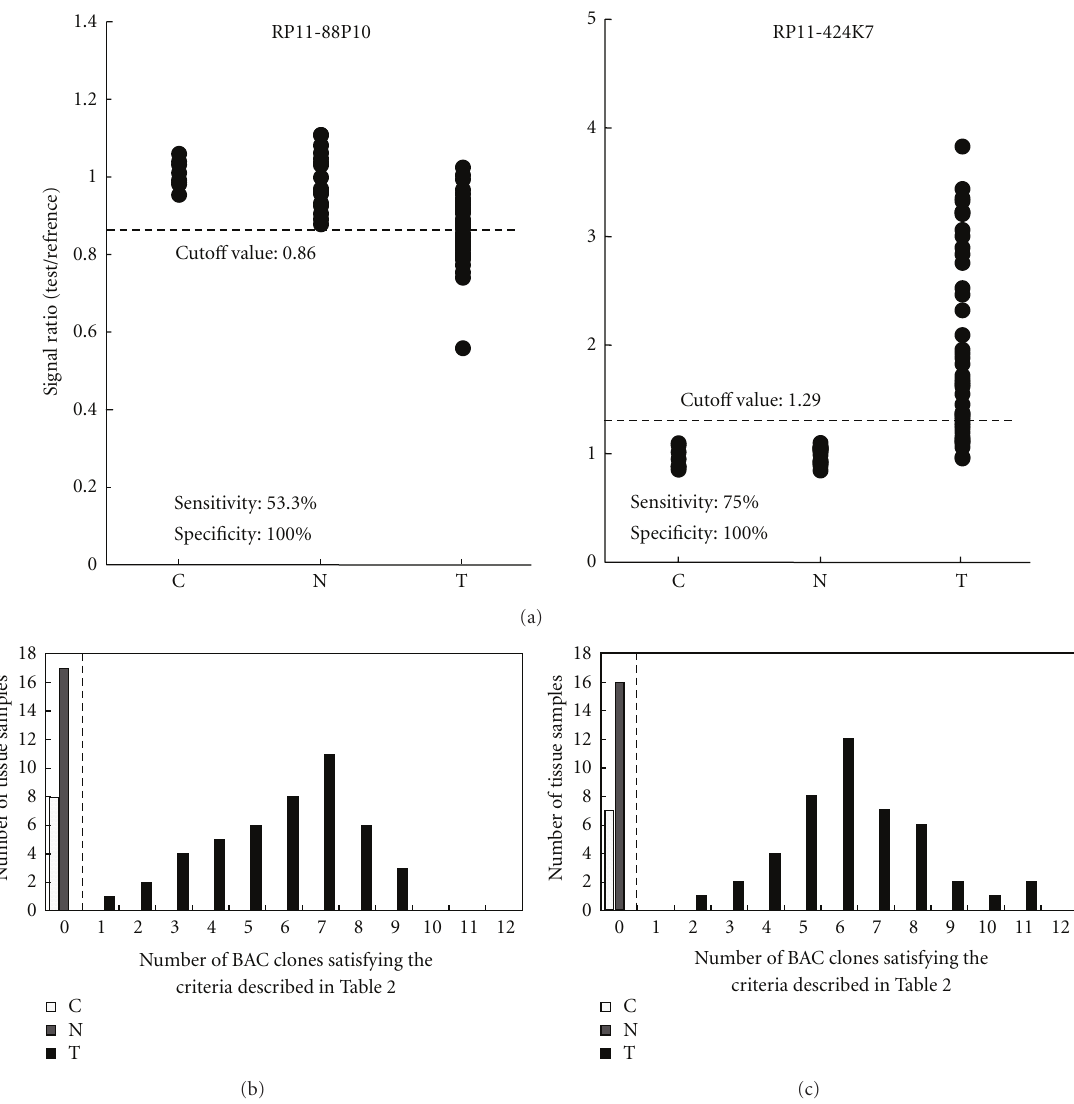
Figure 2: Establishment of criteria for diagnosis of ductal adenocarcinomas of the pancreas. (a) Scattergrams of the signal ratios in samples of normal pancreatic tissue obtained from patients without ductal adenocarcinomas (C), noncancerous pancreatic tissue obtained from patients with ductal adenocarcinomas (N) and cancerous tissue (T) on representative BAC clones, RP11-88P10 and RP11-424K7. Using the cuto ff values indicated by the dotted lines, T-samples were discriminated from both C- and N-samples in the learning cohort with 100% specificity. (b) Histogram showing the number of BAC clones satisfying the criteria listed in Table 2 in the learning cohort ( n = 71). C-, N- and T-samples are indicated by empty, shaded, and filled columns, respectively. Based on this histogram, we established the following criteria: when the tissue samples satisfied the criteria listed in Table 2 for 1 or more BAC clones (dotted line), they were judged to be cancerous tissue, and when tissue samples did not satisfy the criteria for any BAC clone, they were judged not to be cancerous tissue. Based on these criteria, both the sensitivity and specificity for diagnosis of T-samples in the learning cohort as being cancerous were 100%. (c) Validation of the above criteria using 68 additional tissue samples in the validation cohort. All 45 validation samples satisfying the criteria in Table 2 for 1 or more BAC clones (dotted line) were T-samples (filled columns), and all 23 validation samples not satisfying the criteria in Table 2 for any BAC clone were C- (empty column) or N- (shaded column) samples. Both the sensitivity and specificity for diagnosis of T-samples in the validation cohort as being cancerous were again